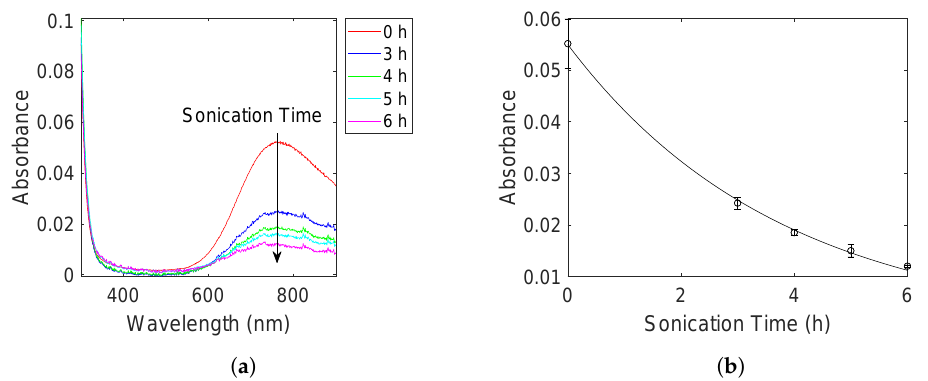
Figure 1. Absorbance spectra of Cu(II) at different sonication times ( a ), and the absorbance at 773 nm plotted as a function of sonication time ( b ). The contribution from other interfering species such as the carbon support and the as-formed nanoparticles were removed by filtration.